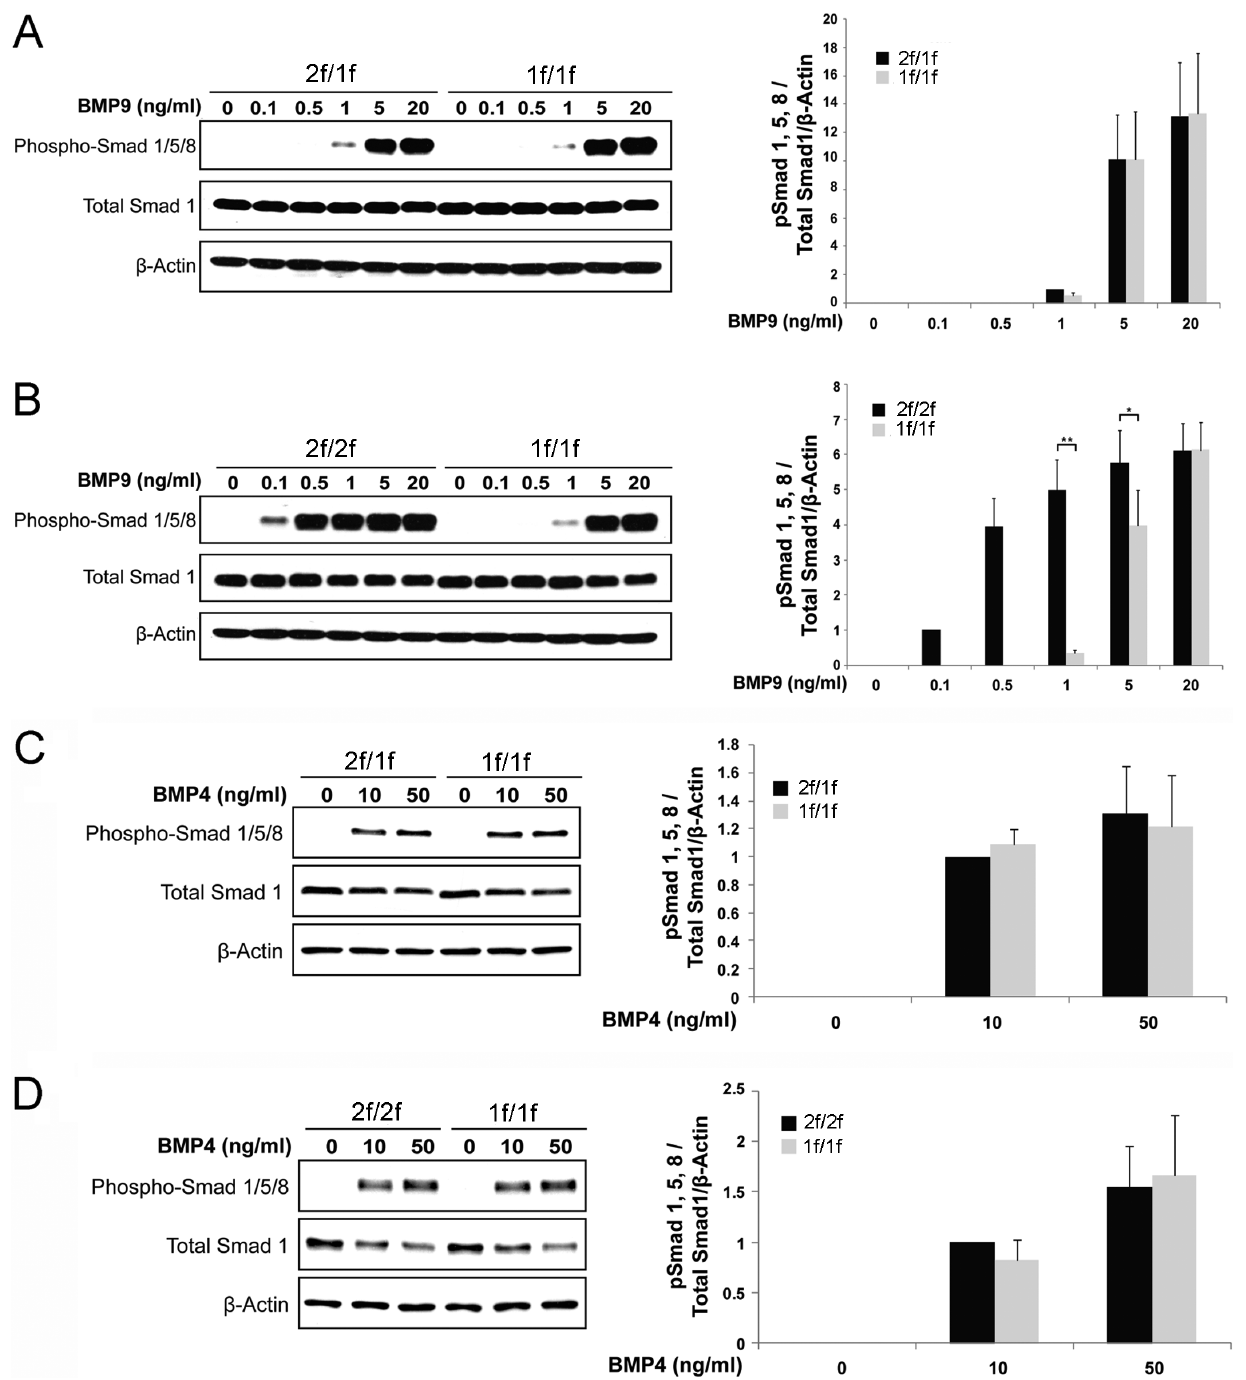
Figure 4. BMP-9-induced SMAD1/5/8 phosphorylation is impaired in both 2f/1f- and 1f/1f-ECs. Western blot showing SMAD1/5/8 phosphorylation, total SMAD1 protein, and b -actin in response to various concentrations of BMP-9 (A, B) and BMP-4 (C, D). A. Comparison of SMAD1/ 5/8 phosphorylation induced by BMP-9 shows no significant difference between 2f/1f and 1f/1f derived from 2f/1f-ECs. B. 2f/2f-ECs are 10-fold more sensitive to BMP-9 than 1f/1f-ECs derived from 2f/2f, suggesting that BMP-9-SMAD1/5/8 signaling is impaired in the 1f/1f-ECs. C and D. There is no difference in SMAD1/5/8 phosphorylation in response to BMP-4 in both 2f/1f (C) and 1f/1f (D) ECs. b -Actin was used as a loading control. Histogram shows phospho-SMAD1/5/8 normalized by total SMAD1 and b -Actin relative to the value indicated by asterisks. Data in all graphs represent means of values measured by densitometry from three separate blots. Error bars are SDs (* p , 0.05 and ** p , 0.01 ).